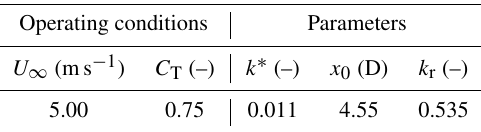
Table 1. Identified model